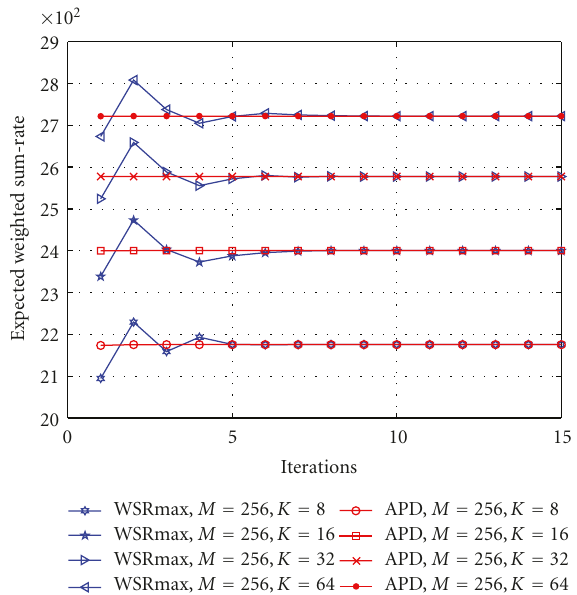
Figure 6: Evolution of expected weighted sum-rate, K = 8,16,32,64 users, M = 256 subcarriers, and SNR =